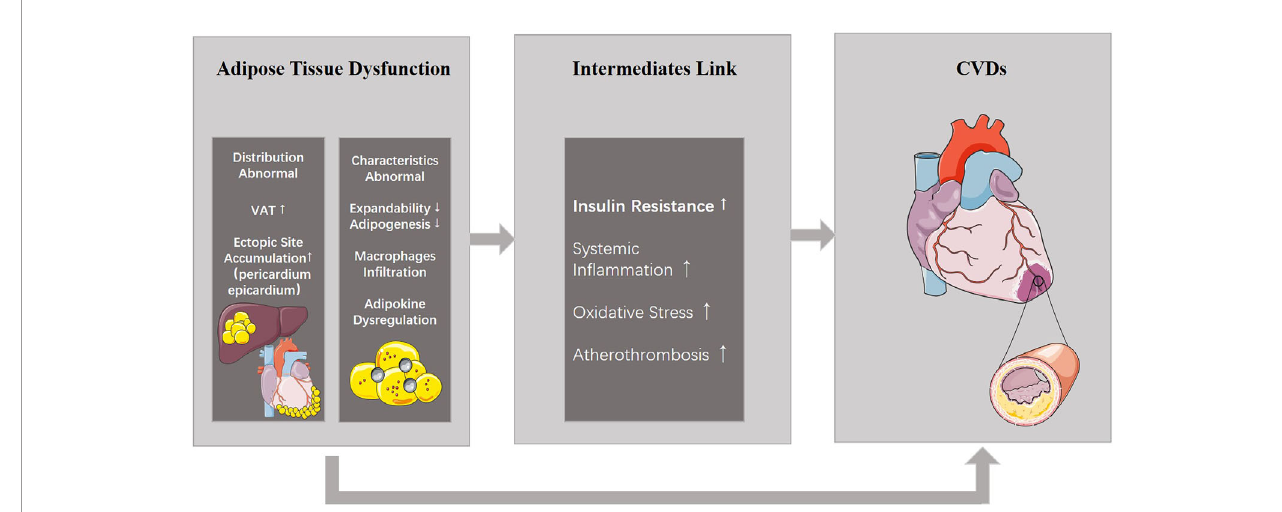
FIGURE 1 | ATD and its relationship with CVDs. ATD consists of two aspects: abnormal distribution and properties. ATD is able to induce CVDs directly, or results in other metabolic diseases including insulin resistance which eventually leads to CVDs. ATD, adipose tissue dysfunction; CVDs, cardiovascular